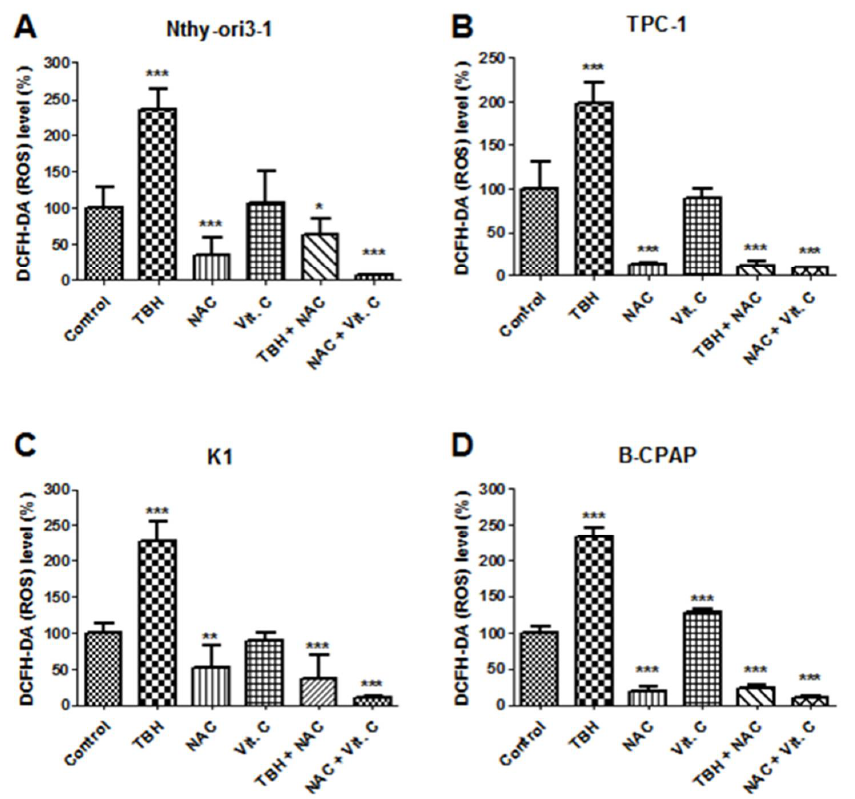
Figure 3. Reactive oxygen species (ROS) levels in PTC-derived cell lines and non-tumoral thyroid cell line, expressed as % of fluorescence of control (untreated cells for each cell line) after treatment with vitamin C 5 mM, TBH 2.5 mM, NAC 10 mM and a combination of TBH+NAC and NAC + vitamin C. ( A ) Nthy-ori3-1, ( B ) TPC-1 ( C ) K1 ( D ) B-CPAP cell lines. Statistical analysis was per- formed by Student t-Test. Results were considered significant vs control when * p < 0.05, ** p <